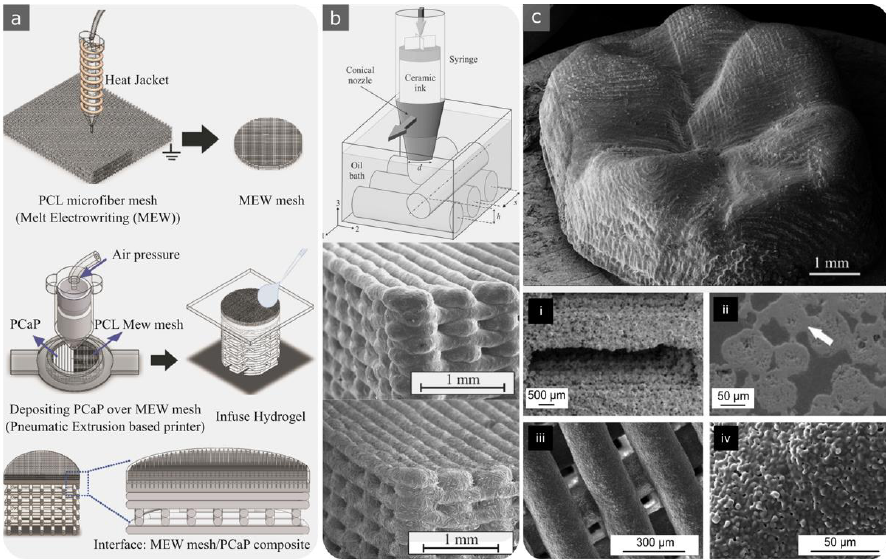
Figure 4. ( a ) An example of a hybrid 3D printing technique used for the fabrication of ceramic- hydrogel connections representing osteochondral interfaces [382]; ( b ) the robocasting fabrication process and SEM images of the scaffolds created by robocasting; the ceramic ink is moved through conical deposition nozzles, which are plunged in an oil bath to create a self-supporting 3D ceramic rod network (reprinted from Ref. [384] with permission, Copyright 2022 John Wiley and Sons); ( c ) SEM micrograph showing the occlusal surface of a zirconia molar crown using the direct inkjet printing technique and SEM images showing hydroxyapatite scaffolds produced by: powder-based 3D printing in ( i ) and ( ii ); direct ink writing in ( iii ) and ( iv ) (reprinted from Ref. [385] with permis- sion, Copyright 2022 John Wiley and Sons).